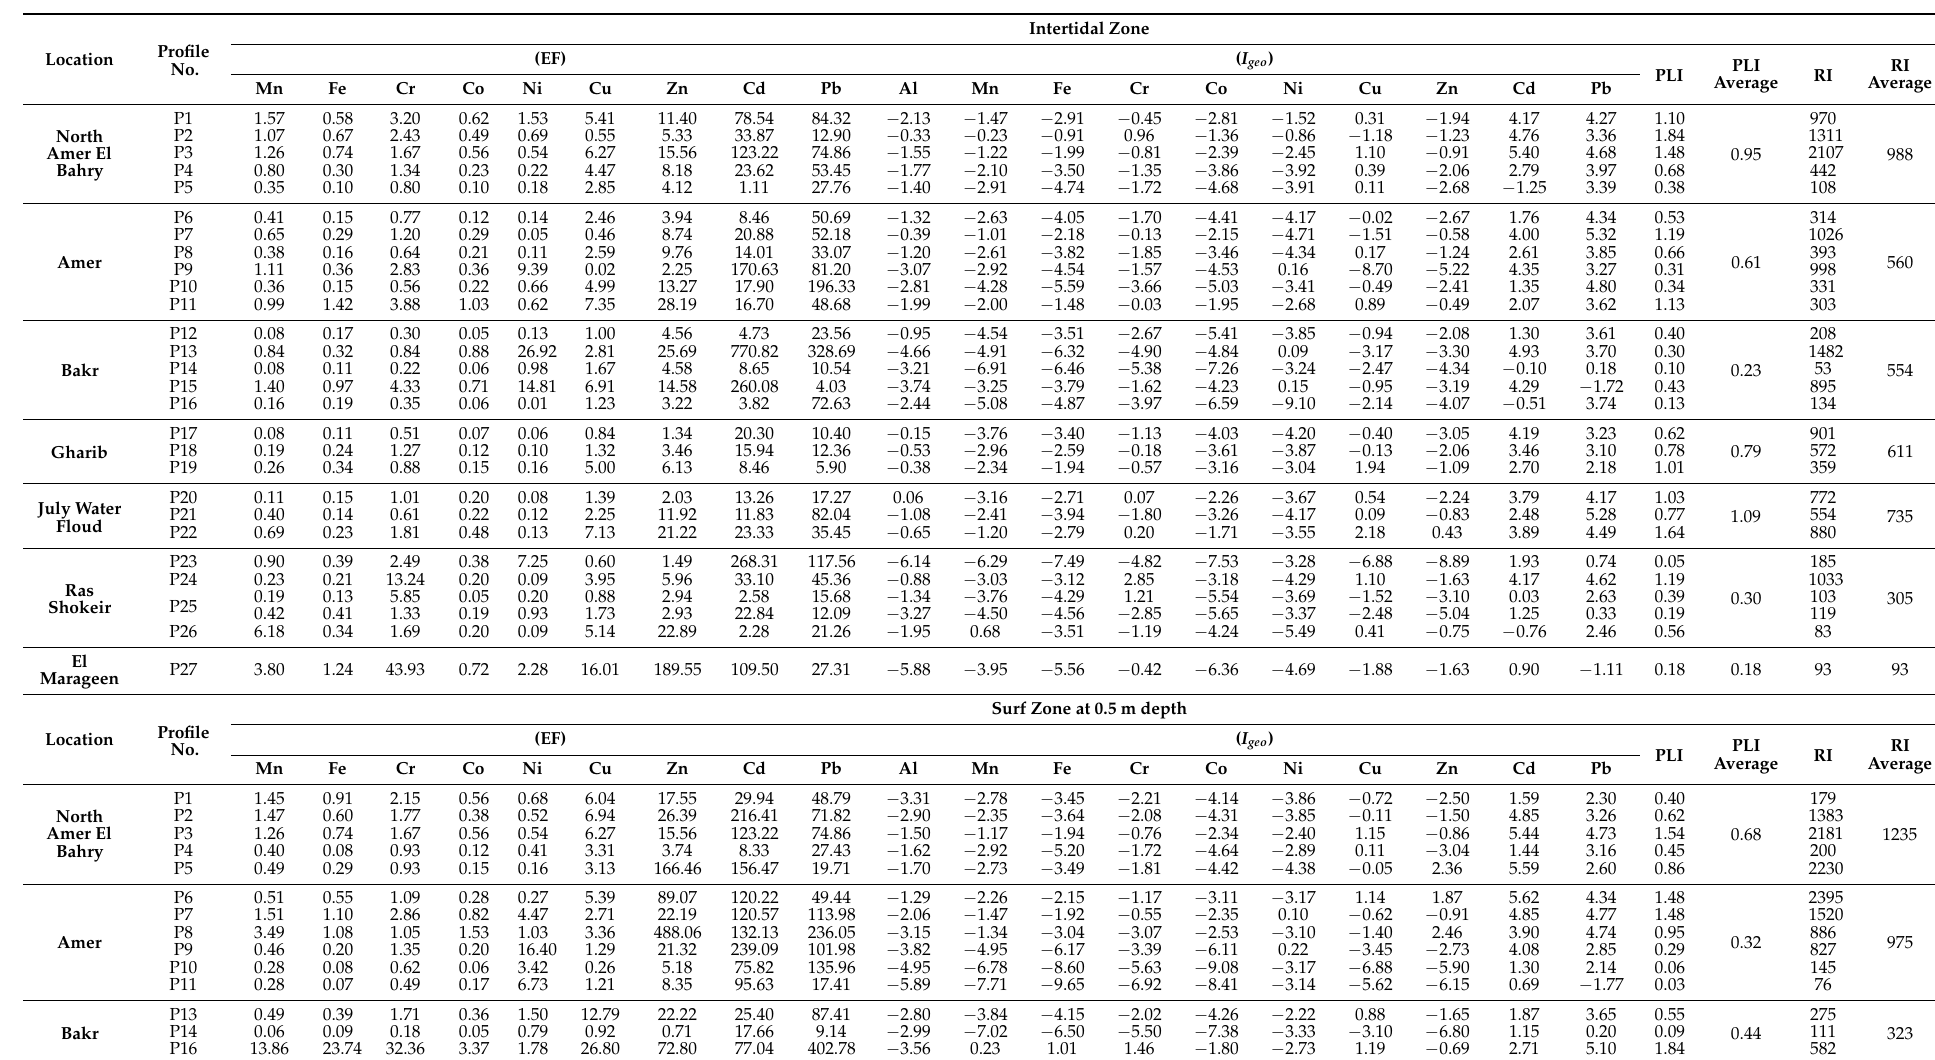
Table 6. Enrichment factor (EF), geoaccumulation index (I geo ), pollution load index (PLI), and risk index (RI) results of metals in sediment samples.